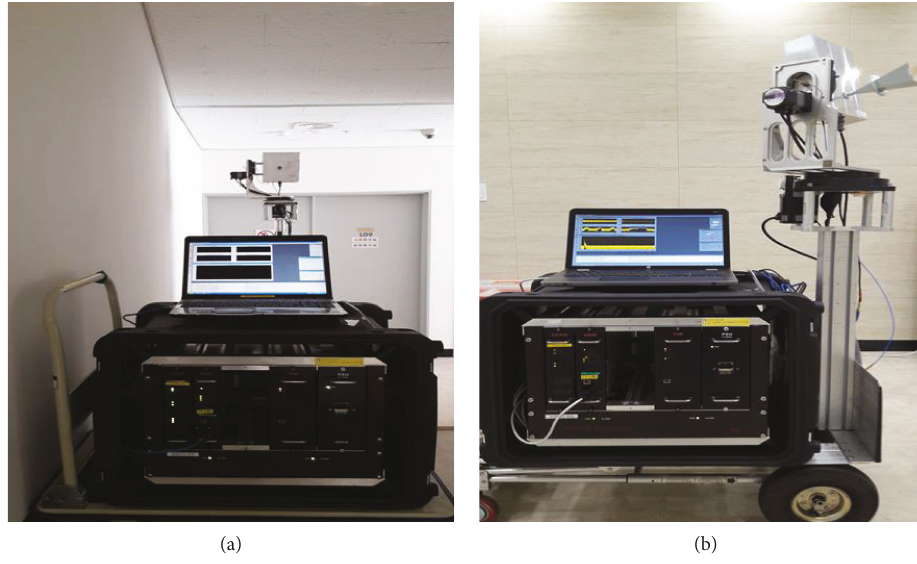
Figure 4: Propagation channeling sounder (transmitter (a) and receiver